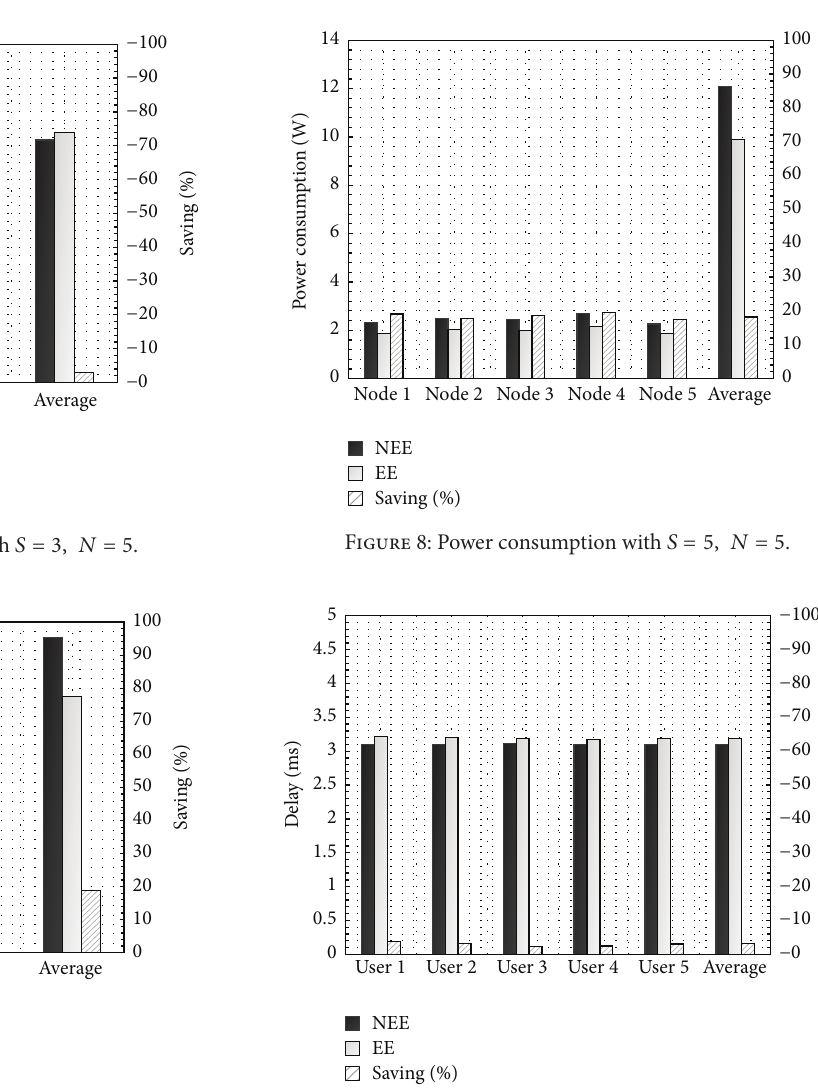
Figure 6: Power consumption with 𝑆 = 5, 𝑁 = 3.